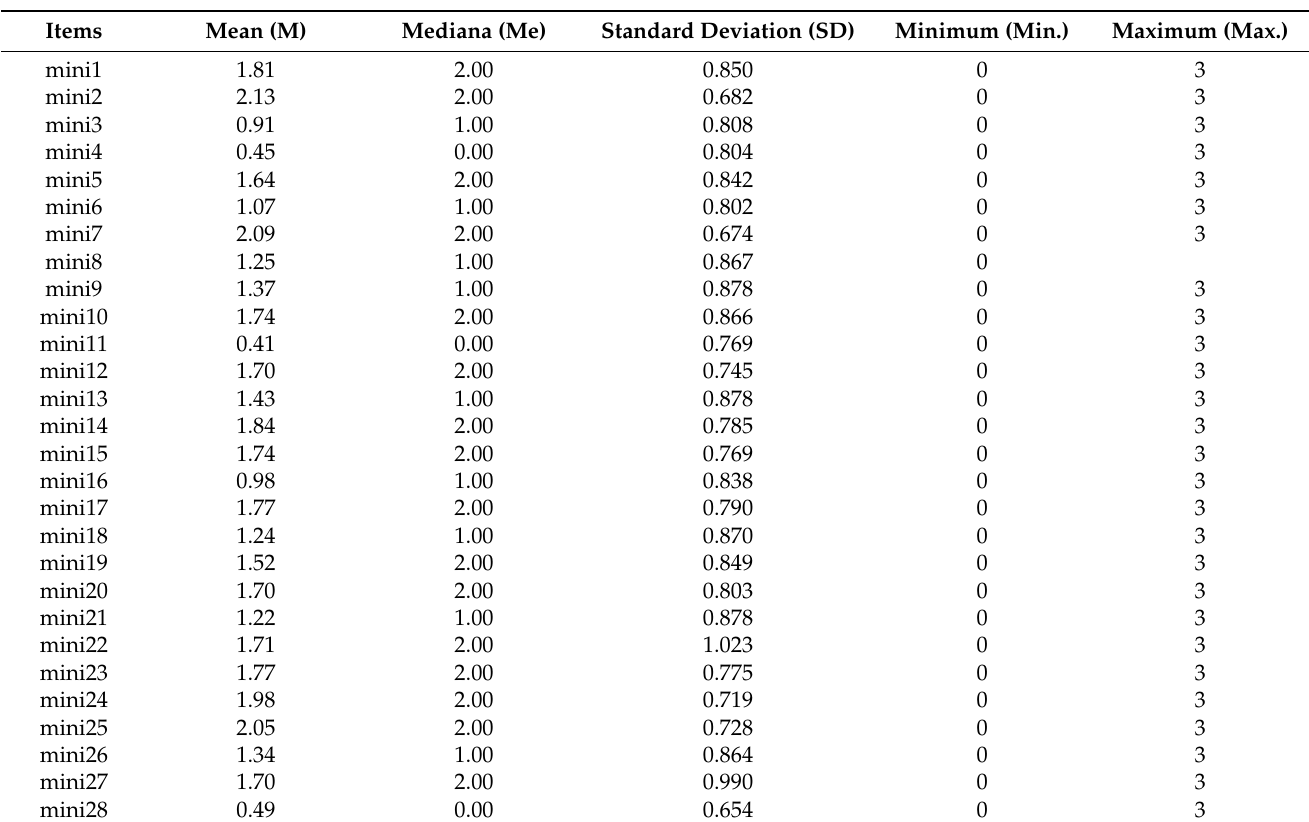
Table 2. Descriptive statistics for the Coping Inventory (MINI-COPE) scores of the participants ( n =